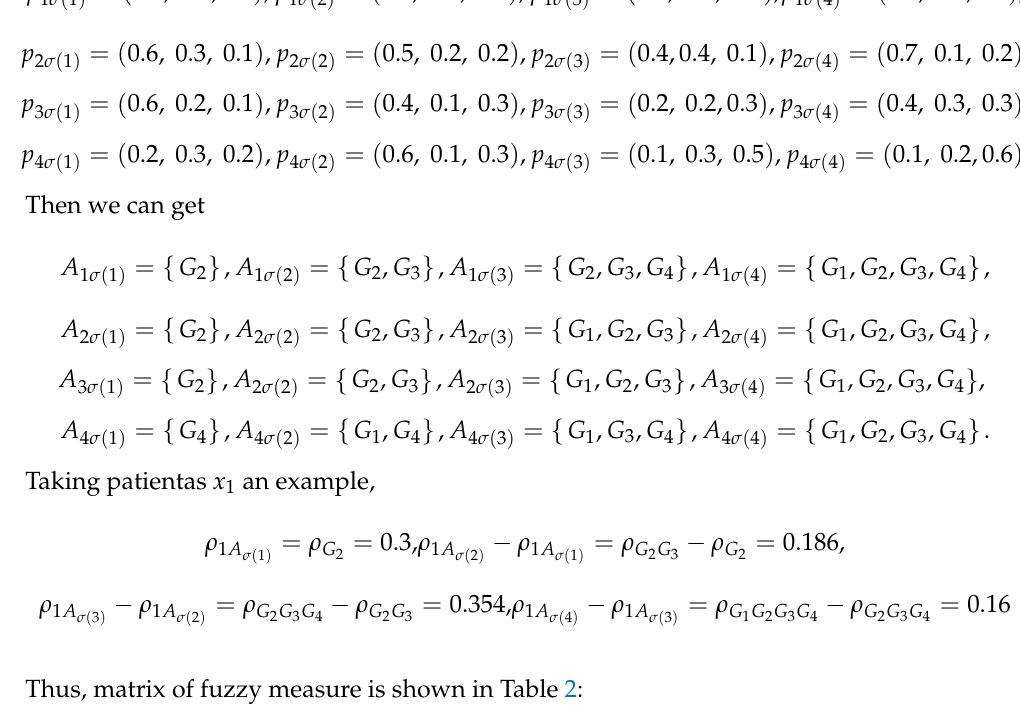
Table 2. Matrix of fuzzy